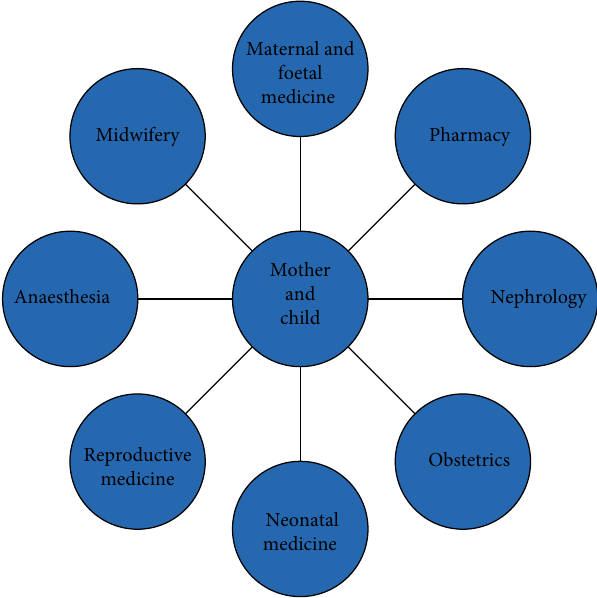
Figure 2: The integrated, multidisciplinary team involved in the provision of co-ordinated care of this high-risk